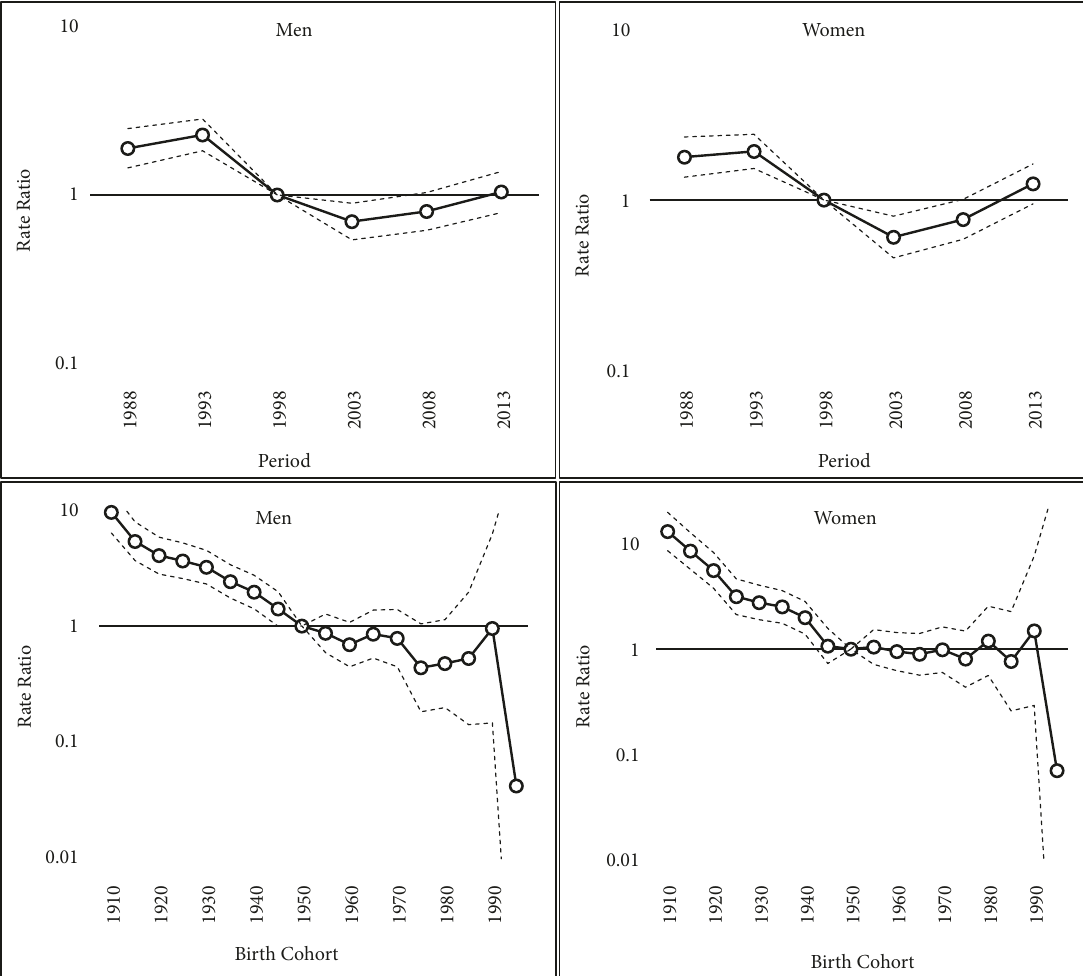
Figure 3: Period and birth cohort effect estimates, with their corresponding confidence intervals, for the mortality of gastric cancer by